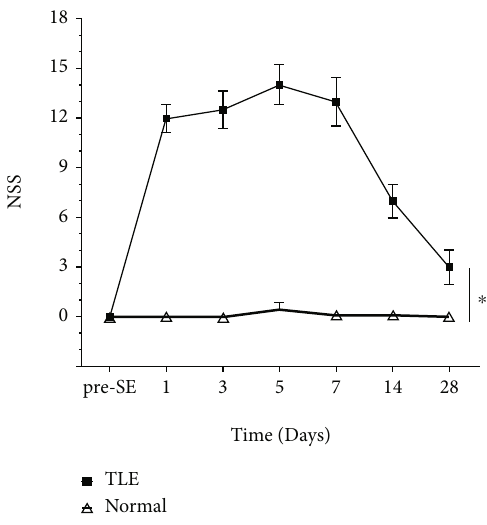
Figure 1: Changes in body weight in TLE rats after SE. Body weight were recorded on D1, D3, D5, D7, D14, and D28 after SE and calculated as the ratio of body weight to standard weight. The data were represented as mean ± SD . ∗ P < 0 : 05 , vs. the normal group.